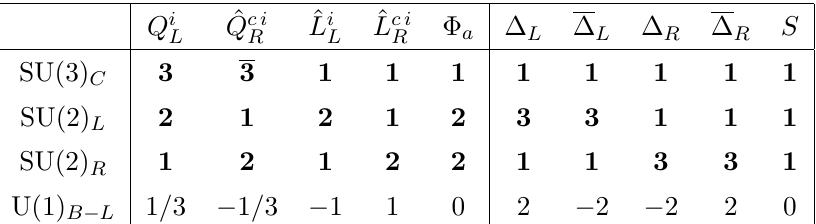
Table 1 . Matter contents of the LR symmetric model with SUSY. i, j = 1 , 2 , 3 are the flavor indices for the quarks and leptons, and a, b = 1 , 2 are the indices for the bi-doublet fields, Φ 1 , 2 . realize the realistic Yukawa coupling. The superpotential of the visible sector is given